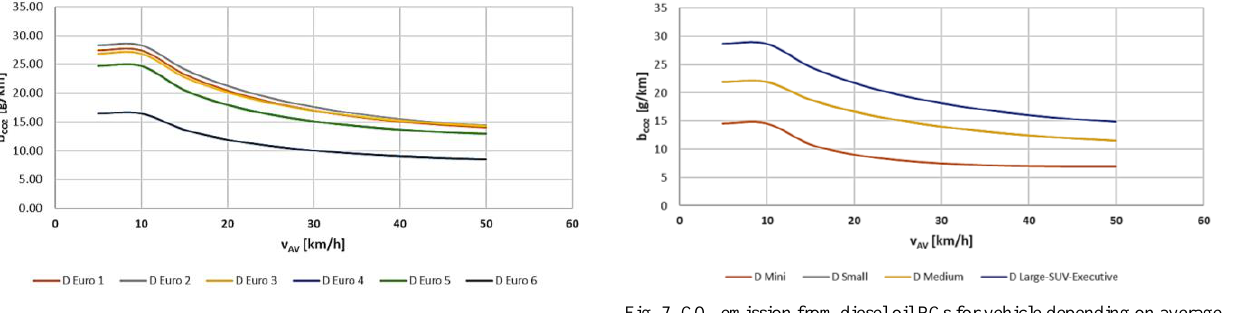
Fig. 3. CO 2 emission from diesel oil PCs for Euro standards depending on average speed